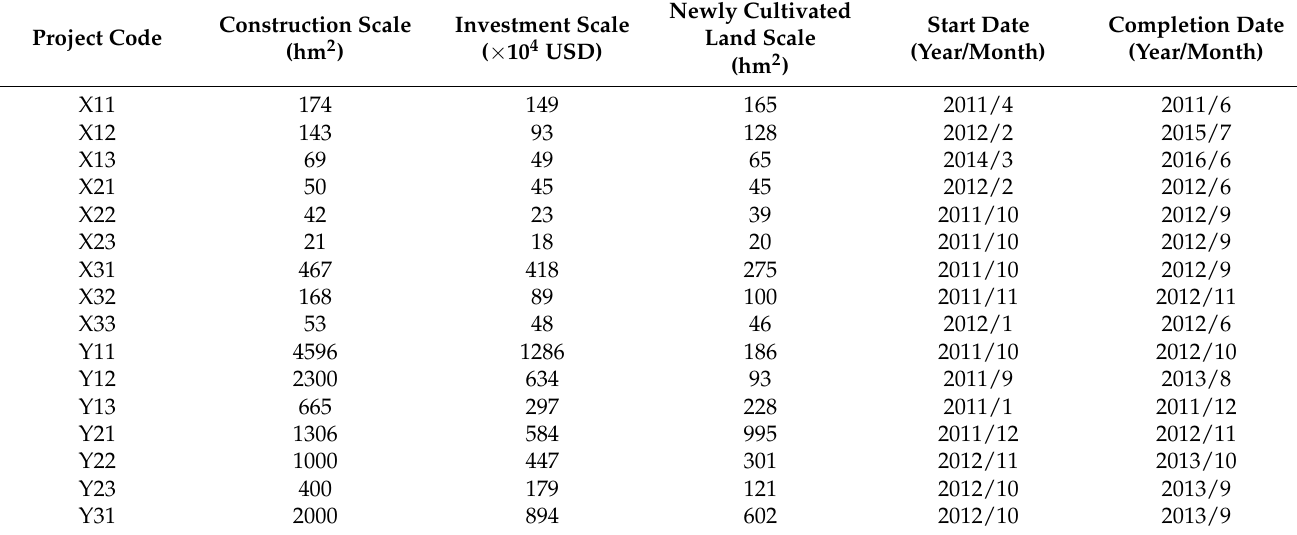
Figure 2. Location map of typical land consolidation project areas in Hubei Province. Table 1. The basic situation of typical land consolidation projects in Hubei Province.